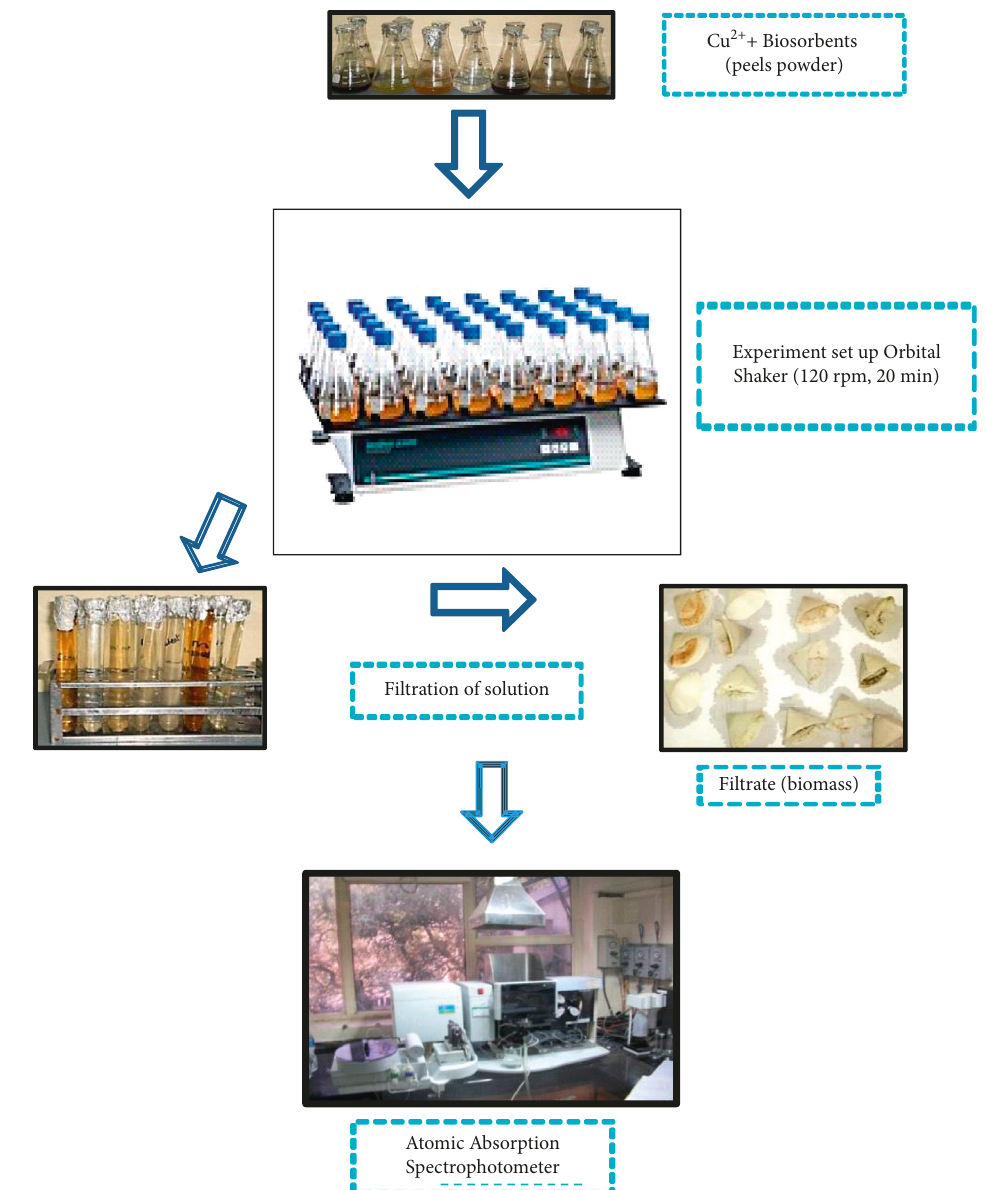
Figure 2: Flow diagram of biosorption